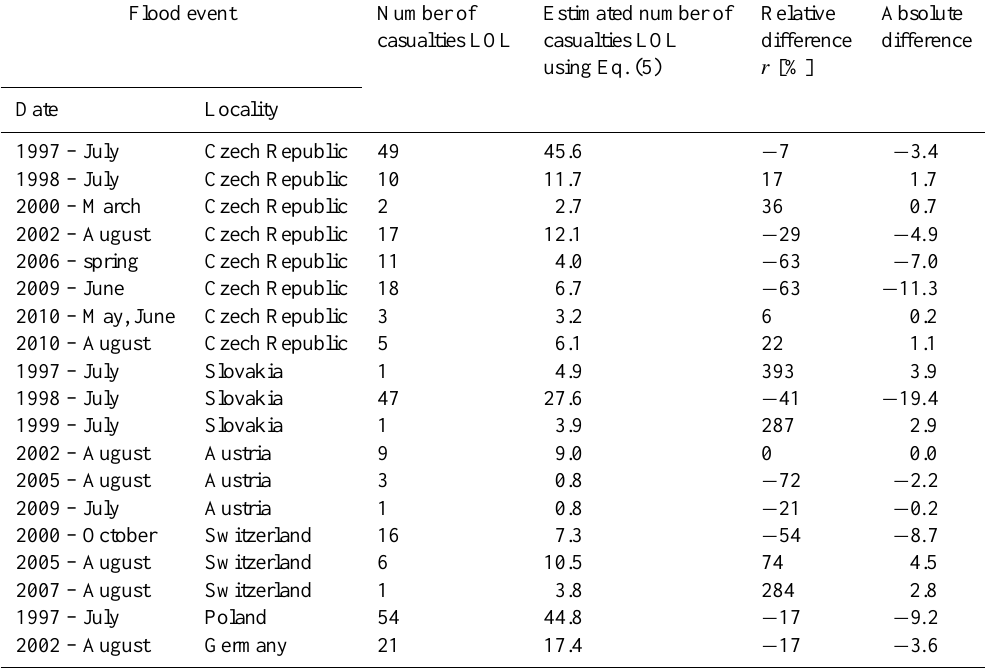
Table 8. Comparison of real casualties with those estimated using Eq. (5). Flood event Number of Estimated number of